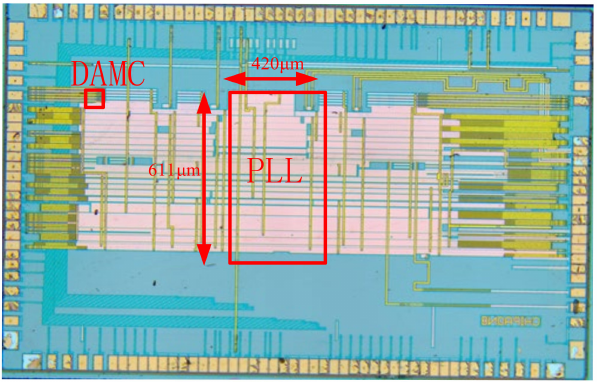
Figure 12. Die photo of the PLL with digital adaptive mismatch calibration.